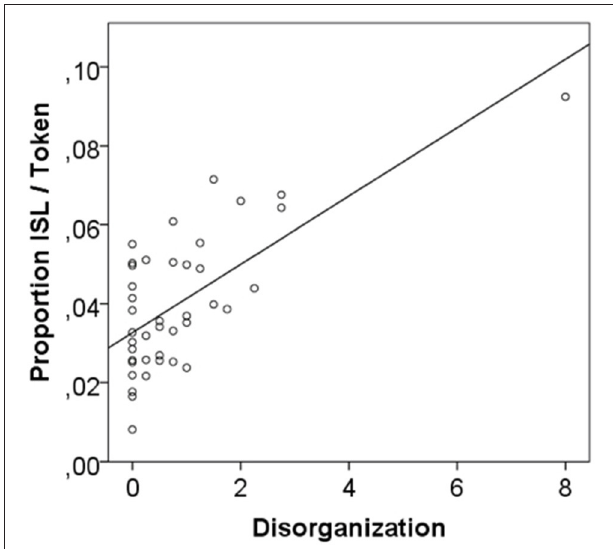
FIGURE 4 | Correlation of patients’ disorganization scores with their use of ISL in the elicited speech production task.